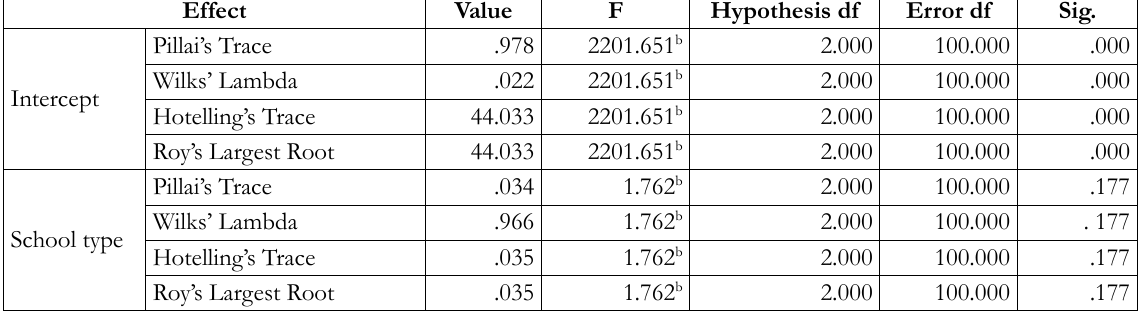
Table 4. MANOVA of School Type on Further Mathematical Ability and physics